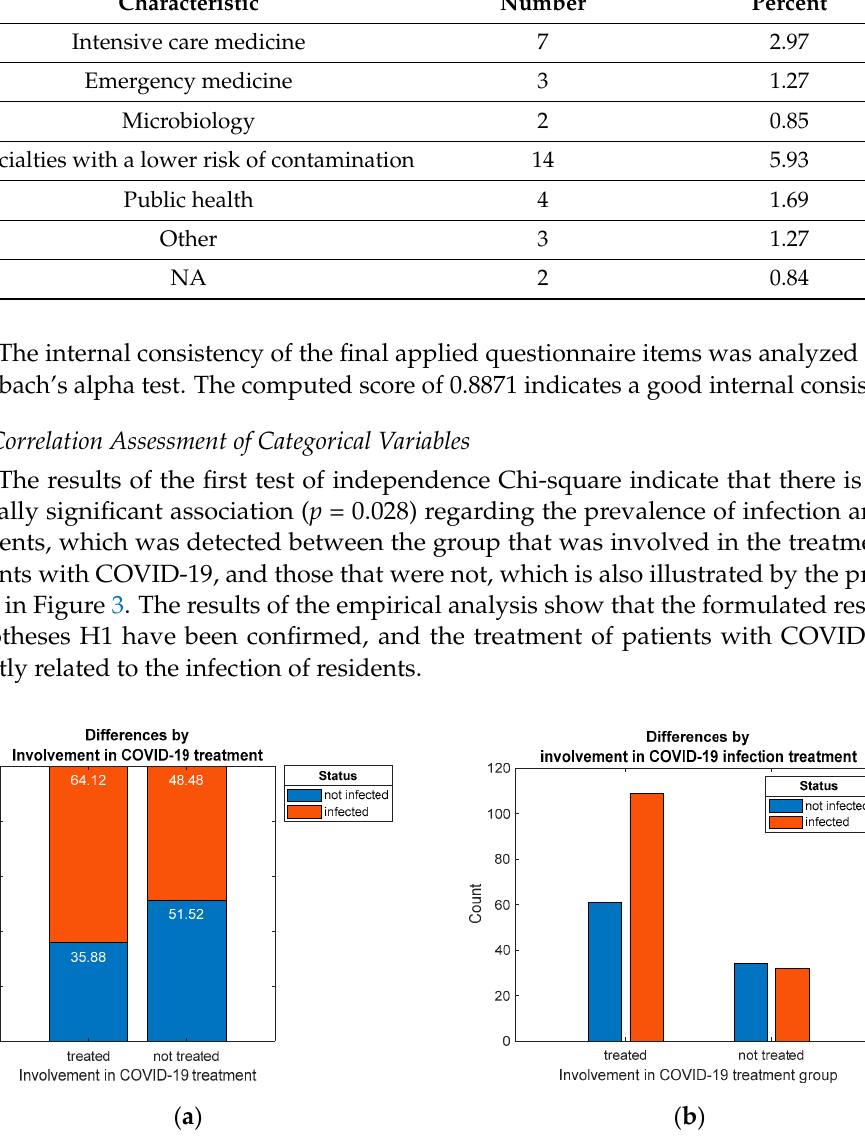
Figure 3. Distribution of respondents by: ( a ) percentage and ( b ) count, considering differentiation by involvement in COVID-19 infection treatment.